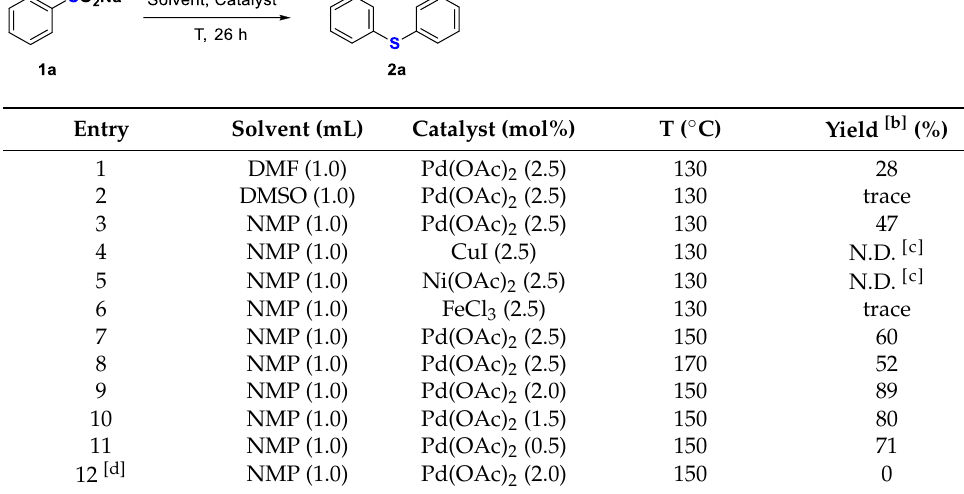
Table 1. Optimization of reaction conditions for sodium benzenesulfinate to diphenylsulfide [a] .